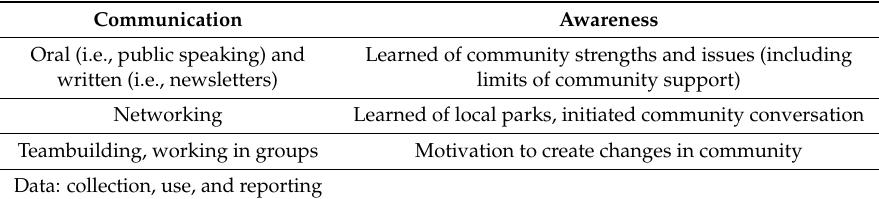
Table 1. Categories and themes from